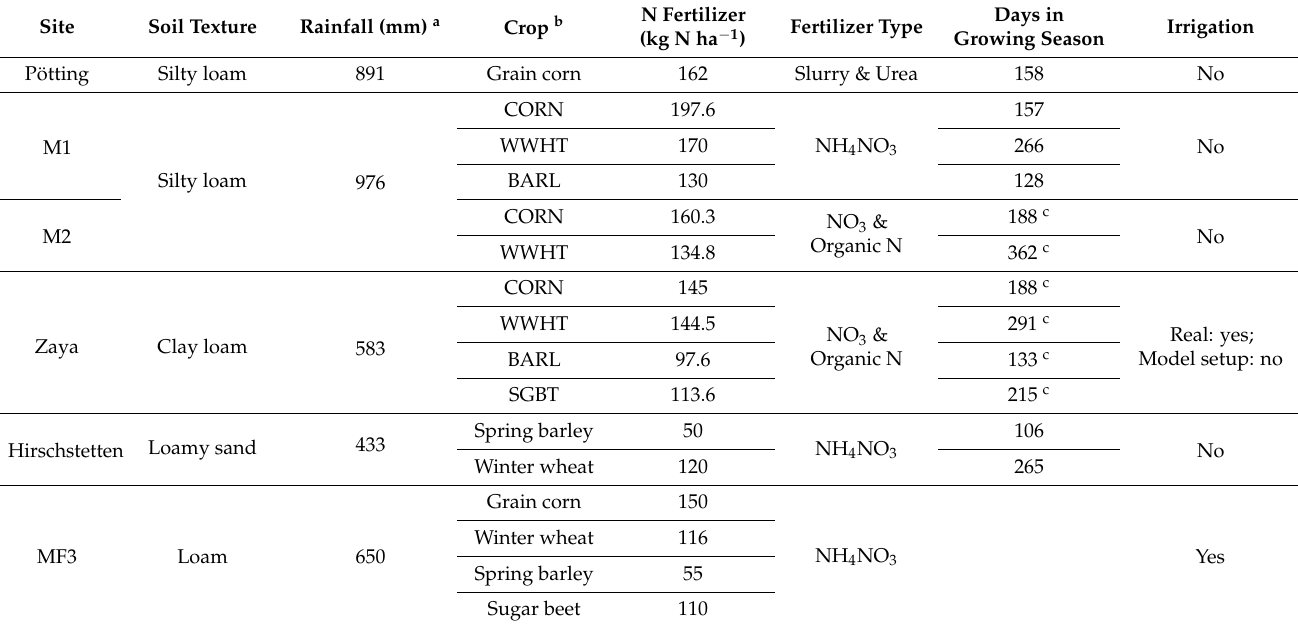
Table 3. Site characteristics of Pötting, Melk, Zaya, Hirschstetten, and